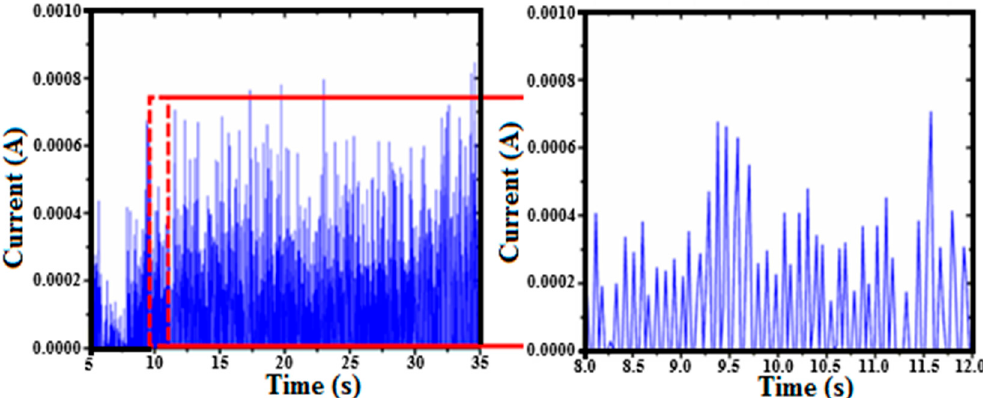
Figure 17. Combined (TENG-EMG) short circuit analysis at a rotational speed of 251 rpm.